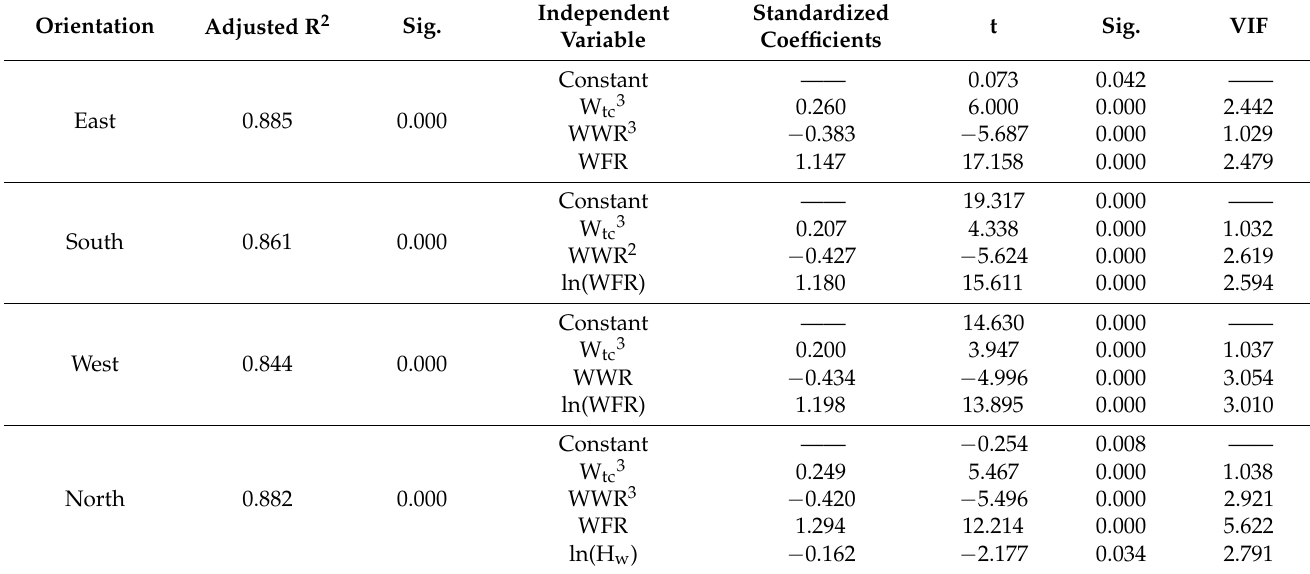
Table 3. Comprehensive analysis results of multiple regression models of sDA 300,50% in differently orientated terrace